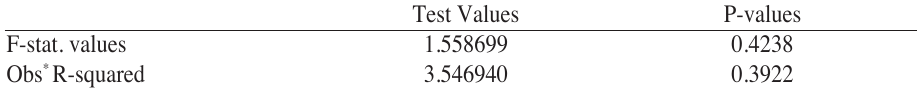
Results of Stability and Specification of Variables